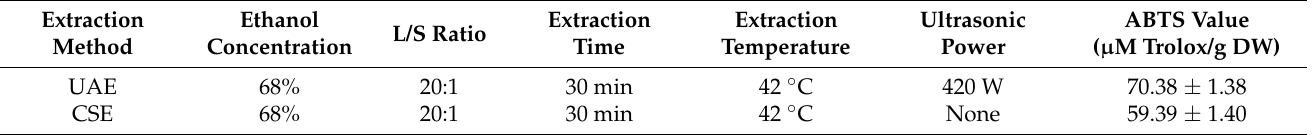
Table 4. ABTS value comparison between ultrasound-assisted extraction (UAE) and conventional solvent extraction